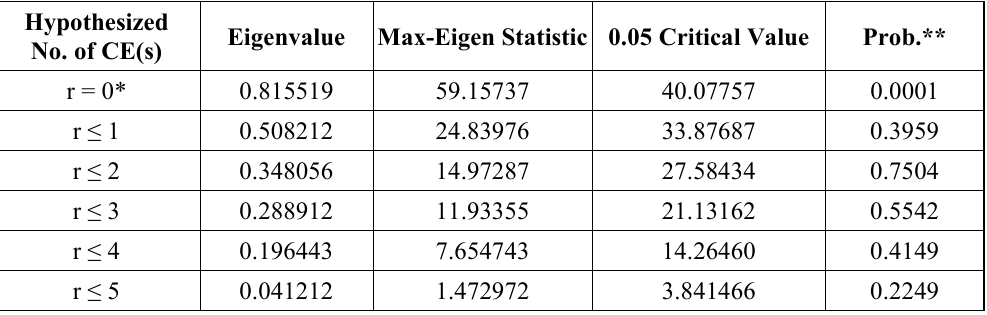
Table 5. Unrestricted Cointegration Rank Test (Maximum Eigenvalue)